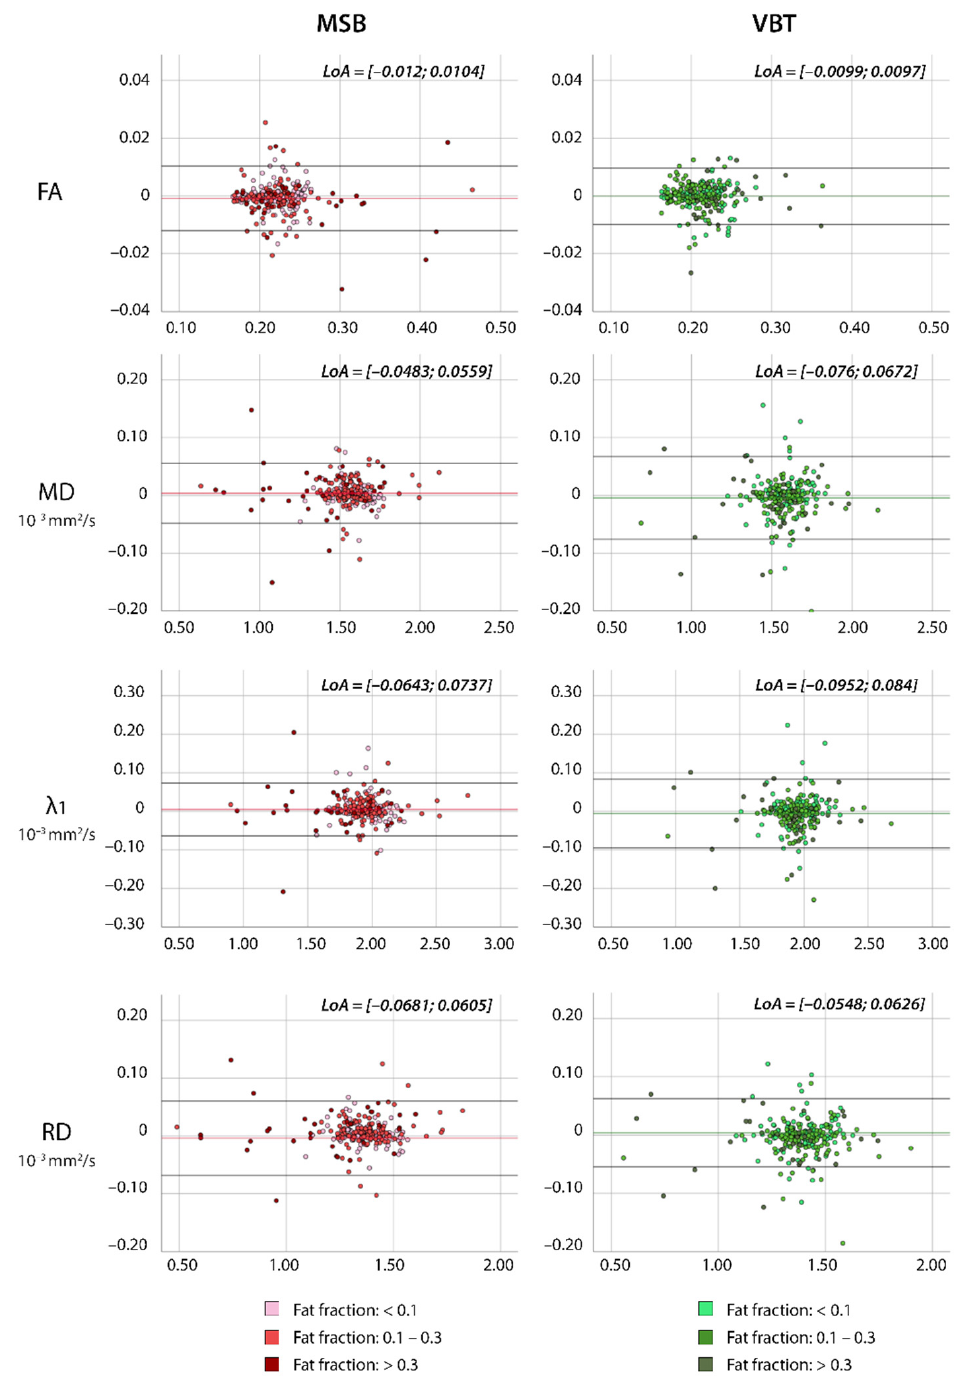
Figure 5. Bland-Altman plots of inter-rater measurements for MSB and VBT in individuals with neuromuscular diseases. The x-value shows the mean of two raters, and the y-value the difference between the raters. The colored lines show the mean of the paired difference; the black lines show LoAs from − 1.96 s to 1.96 s.